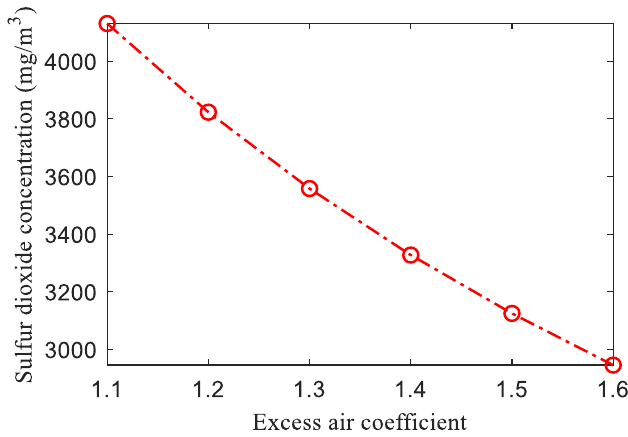
Figure 2. The influence of the theoretical SO 2 concentration of excess air coefficient.